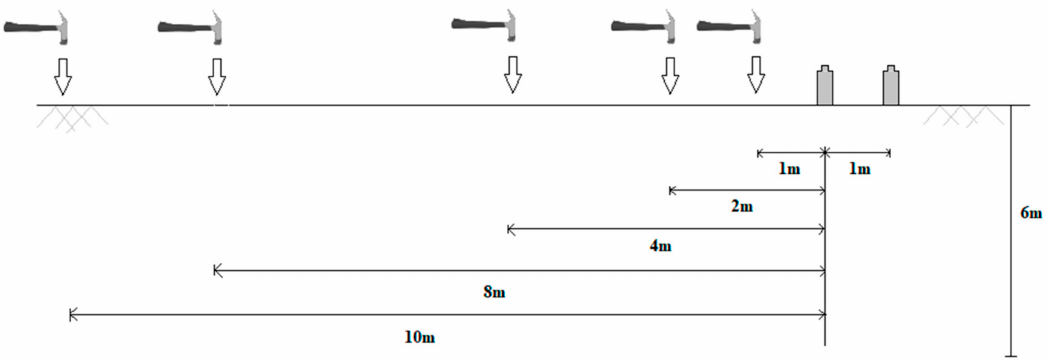
Figure 9. Configuration of equipment for SASW